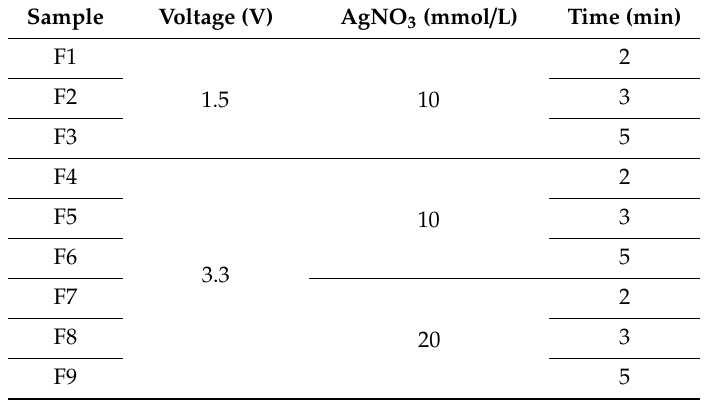
Table 1. Electrodeposition parameters for the SiO 2 –hydroxyapatite (HA)